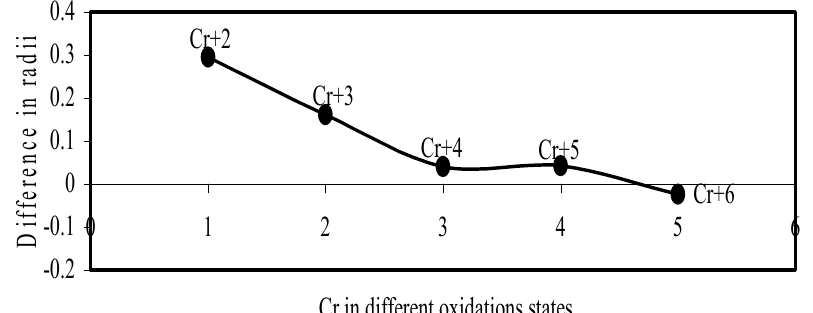
Figure 16. Plot of difference in experimental and theoretical radii of Cr in different oxidation states.